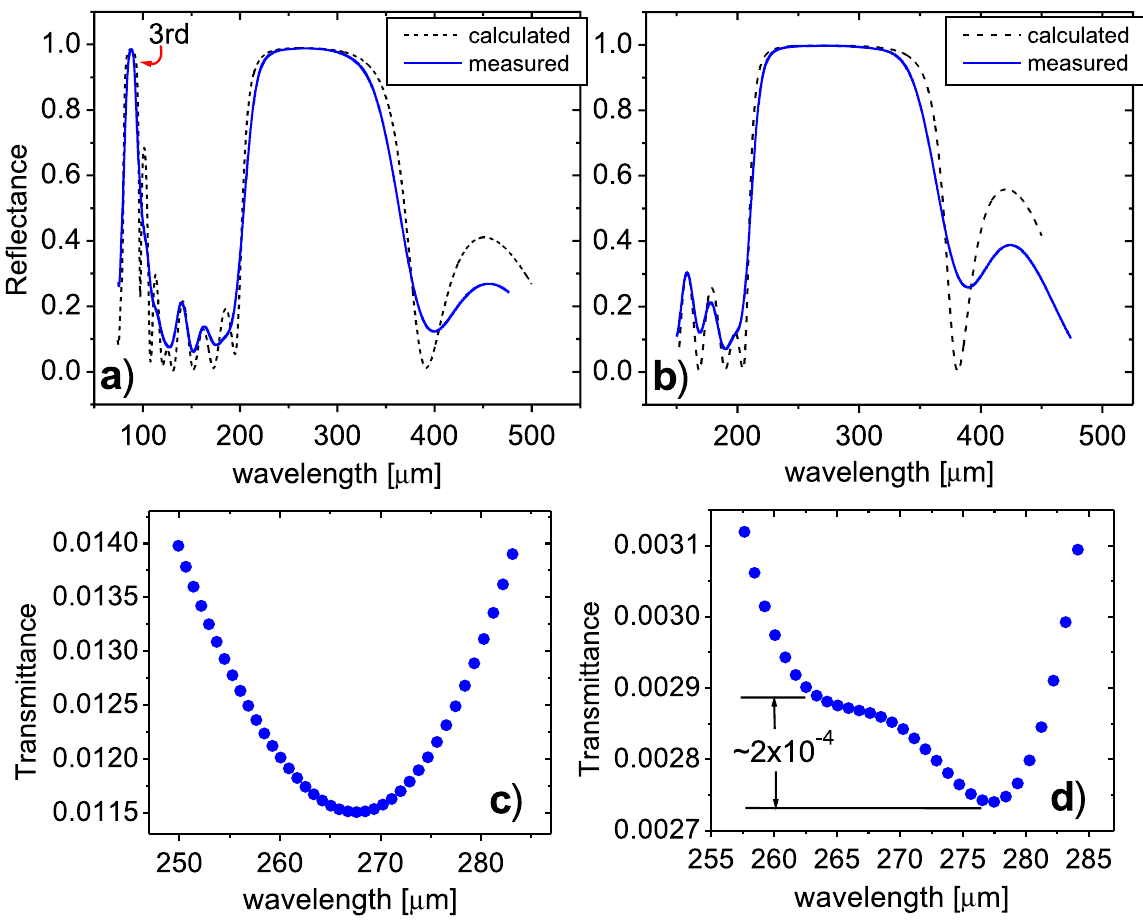
FIG. 6. (Color) Numerically calculated reflectance (dashed line) and reflectance (solid line) obtained from the measured transmittance spectra are depicted for the four layer (a) and the five layer (b) quartz PhC. The respective transmittance spectras around the band gap center are shown in (c) and (d). The asymmetric behavior present in (d) is due to a small defect arising from an imperfection in one of the quartz layers. The transmittance data of each plot is recorded with 2 cm (cid:2) 1 spectral resolution and averaged over 160 samplings.